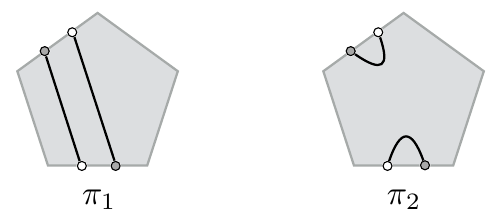
Figure 7 . Cartoon of the matrix structure of the Z A (cid:22) Z B ! Z C (cid:22) Z D transitions. There are two structures for the two possible ways of contracting indices, (cid:25) 1 (cid:14) C for the (cid:12)rst few terms in the asymptotic limit (cid:27)